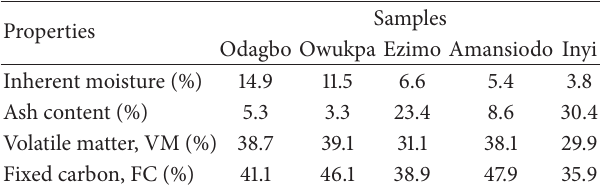
Table 1: Results of proximate analyses of the five coal